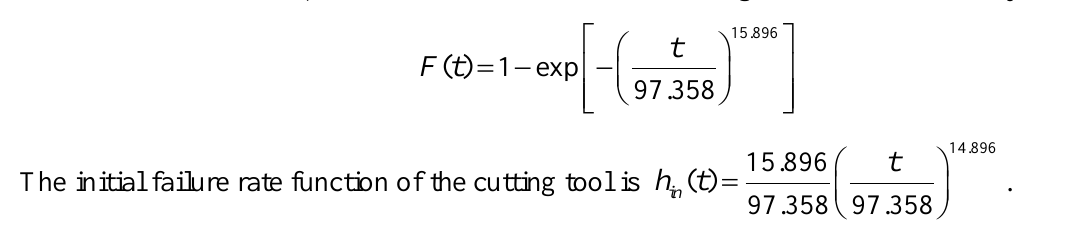
Figure 5. Weibull distribution fitting